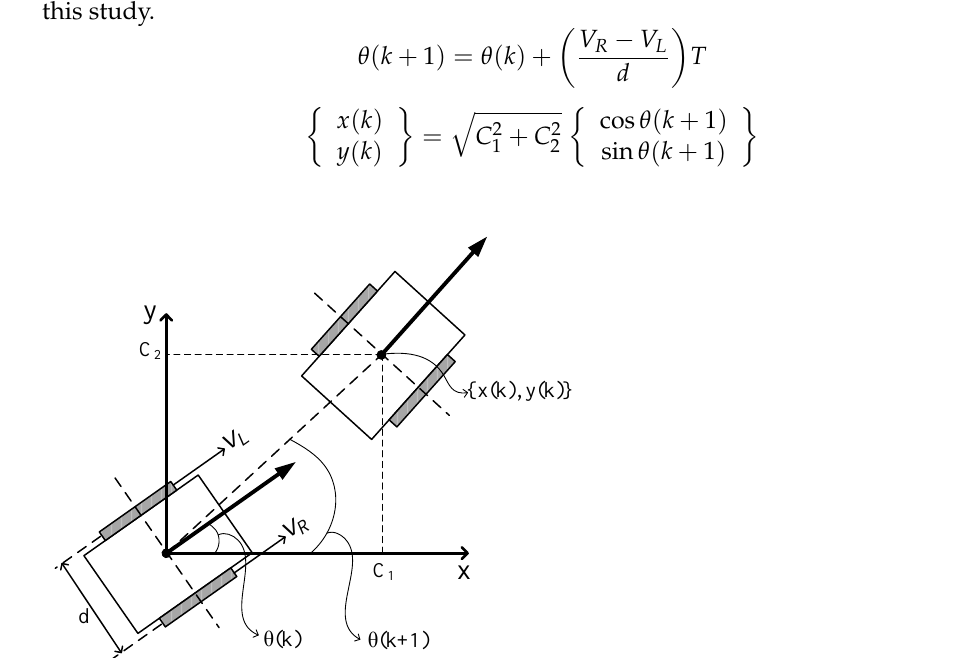
Figure 12. Parameters influencing simulation of robot motion.